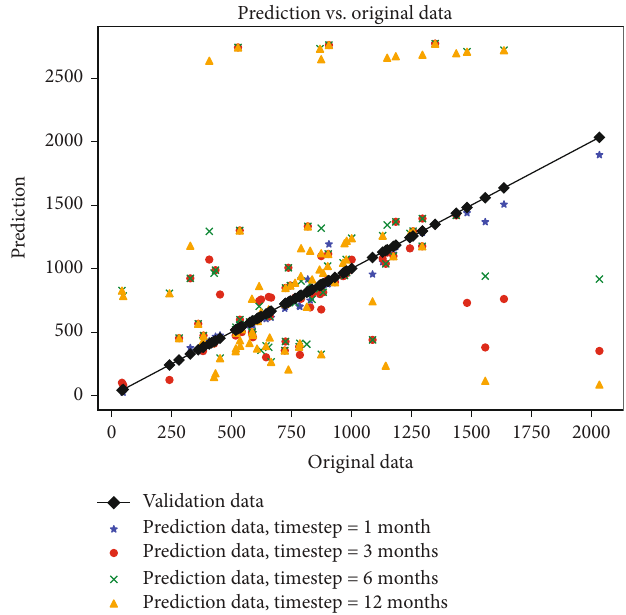
Figure 17: Cross-plot of prediction and oil production